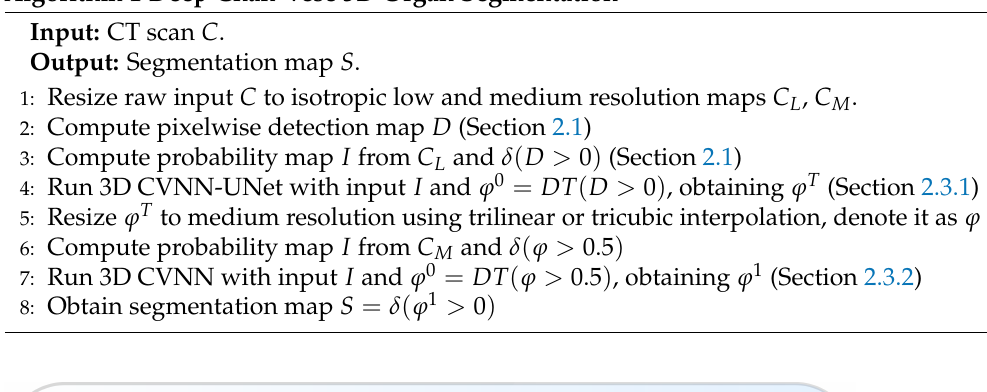
Algorithm 1 Deep Chan-Vese 3D Organ Segmentation